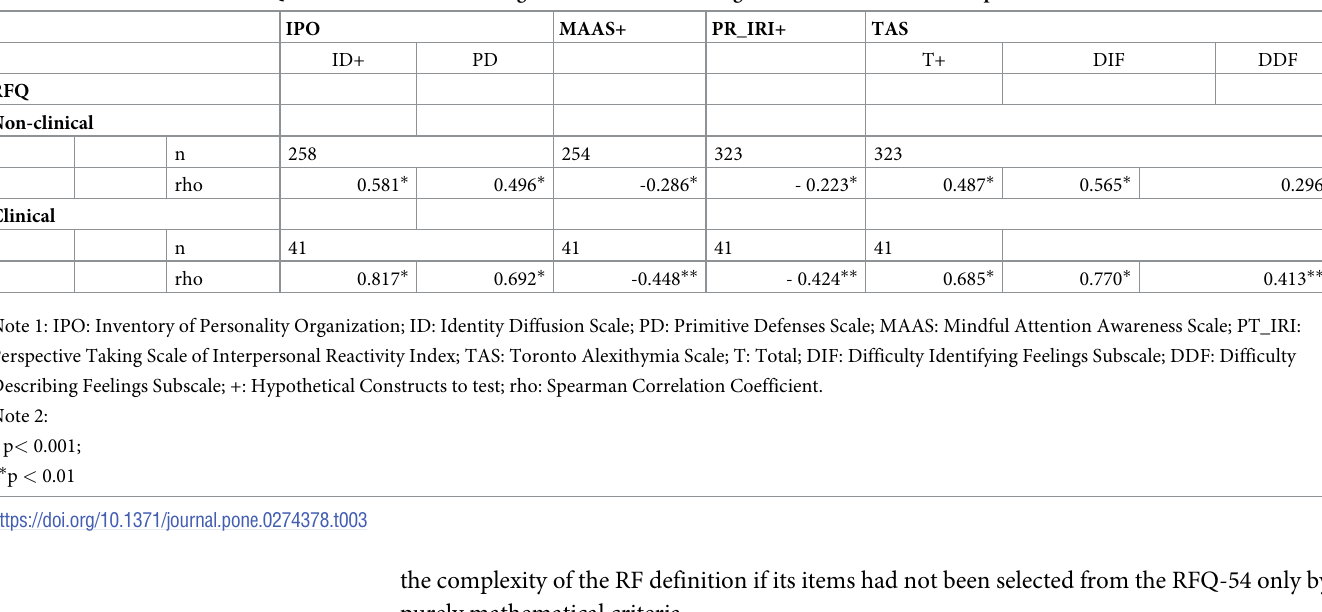
Table 3. Correlations between RFQ and measures of mentalizing-related constructs among non-clinical and clinical